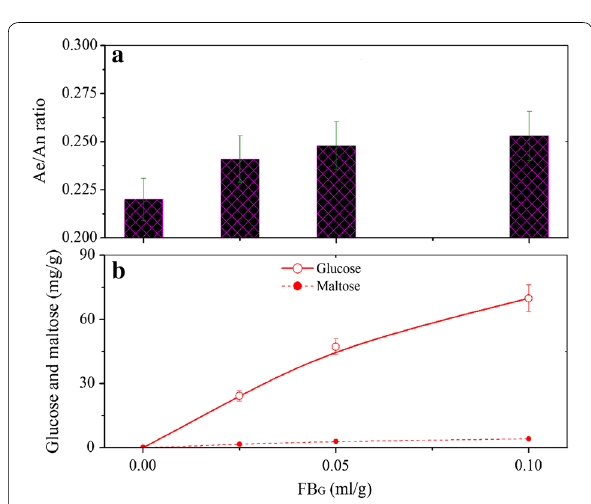
Fig. 8 Variations of Ae/An ratio as well as glucose and maltose content with the FB G dosage. a Variation of Ae/An ratio; b variations of glucose and maltase